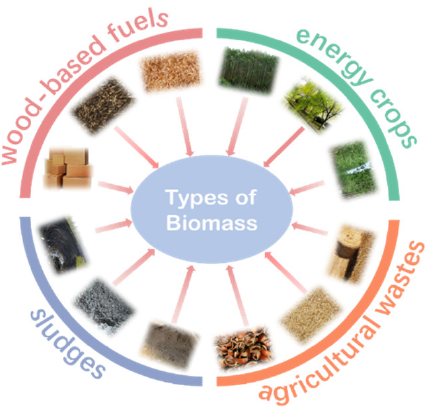
Figure 1. Types of biomass feasible for heat and power generation [3].